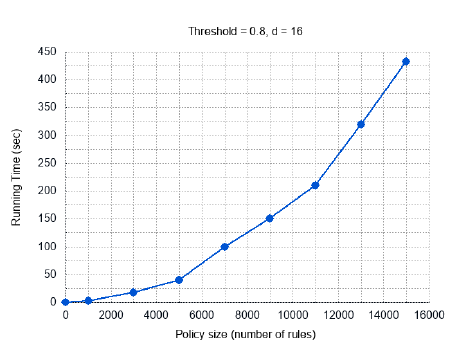
Figure 3. Running time of Algorithm 1 Figure 4. Total running time